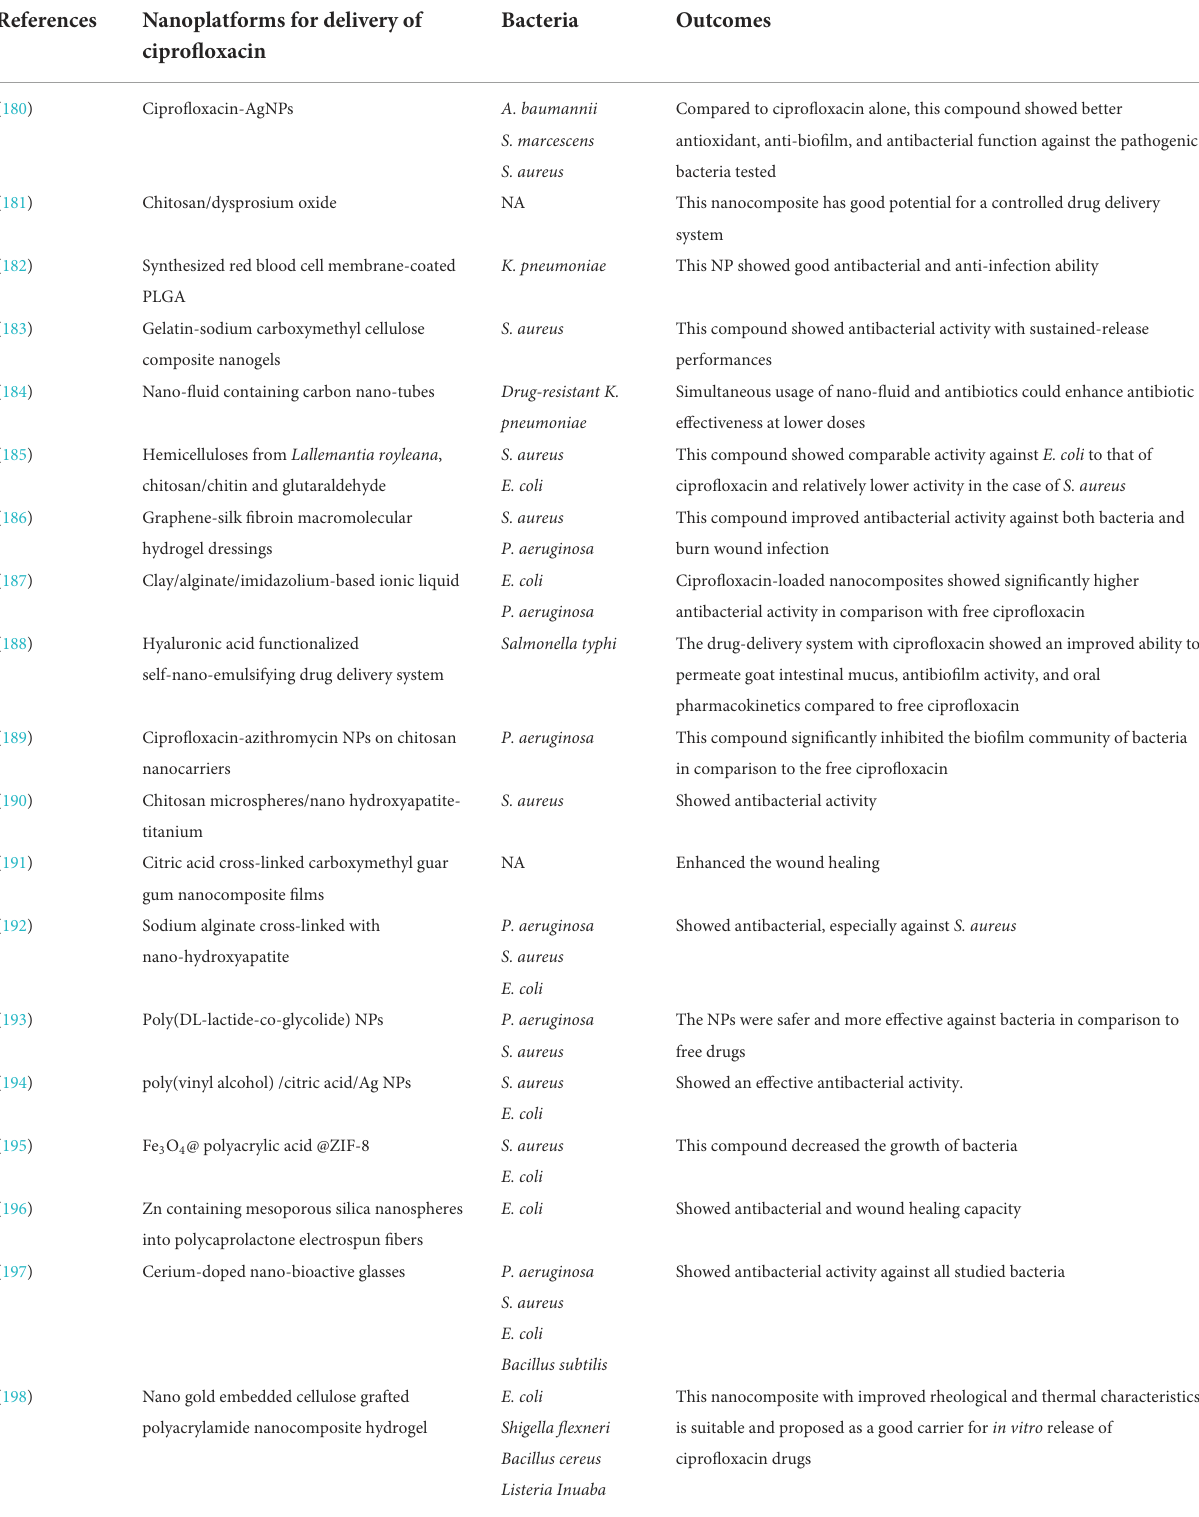
TABLE 4 The studies have used nano-platform for the enhancement of ciprofloxacin against different